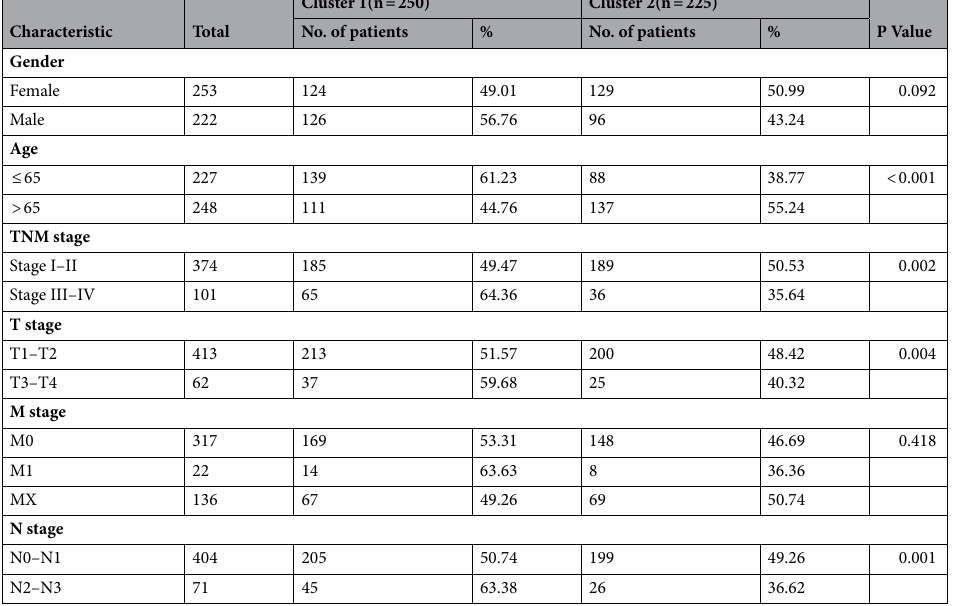
(Fig. 6A, Table S2). The prognostic value of these 12 miRNAs was evaluated via the Kaplan ‒ Meier Plotter data- base. There were 3 upregulated miRNAs associated with OS (hsa-miR-196b, hsa-miR-31, hsa-miR-9). Survival analysis showed that high expression of hsa-miR-196b, hsa-miR-31, and hsa-miR-9 in LUAD was associated with worse OS (Fig. 6B–D; HR = 1.68, 1.86, 1.49, respectively; all P < 0.01). Identification of candidate target DEGs regulated by prognosis‑related miRNAs. Target genes of miRNAs (hsa-miR-9, hsa-miR-31, hsa-miR-196b) were obtained via the mirDIP database, and those sup- ported by four or more databases were regarded as candidate target genes for further analysis (Fig. S2). The intersection of candidate target genes and the top 50% of downregulated genes was identified through a Venn diagram (Fig. 6E). Three target genes ( PCSK2, FREM2, ALPL ) in hsa-miR-9, two ( ATP1A2, PRSS12 ) in hsa- miR-196b, and one ( CEBPA ) in hsa-miR-31 were identified. Except for PRSS12 , other target genes were related to prognosis, and we defined them as candidate target DEGs ( PCSK2, FREM2, ALPL, ATP1A2, CEBPA ). All candidate target DEGs were downregulated in the relative hypoxia group (Cluster 1), and low expression was associated with poor survival (HR=0.71, 0.59, 0.74, 0.67, 0.55, respectively, all P < 0.05, Fig. 6F–J). Hypoxia‑related competitive endogenous RNA (ceRNA) regulation network. Target lncRNAs of hsa-miR-196b, hsa-miR-31, and hsa-miR-9 were predicted via the StarBase database, and those that were negatively related to the candidate miRNAs (Fig. 6K) and positively related to the candidate target DEGs were selected (Table 2). Finally, 6 candidate lncRNAs were selected (NEAT1, AC000123.3, ARHGAP27P1-BPTFP1- KPNA2P3, AC020978.7, AC021078.1, MIR497HG). The local protein network between candidate target DEGs